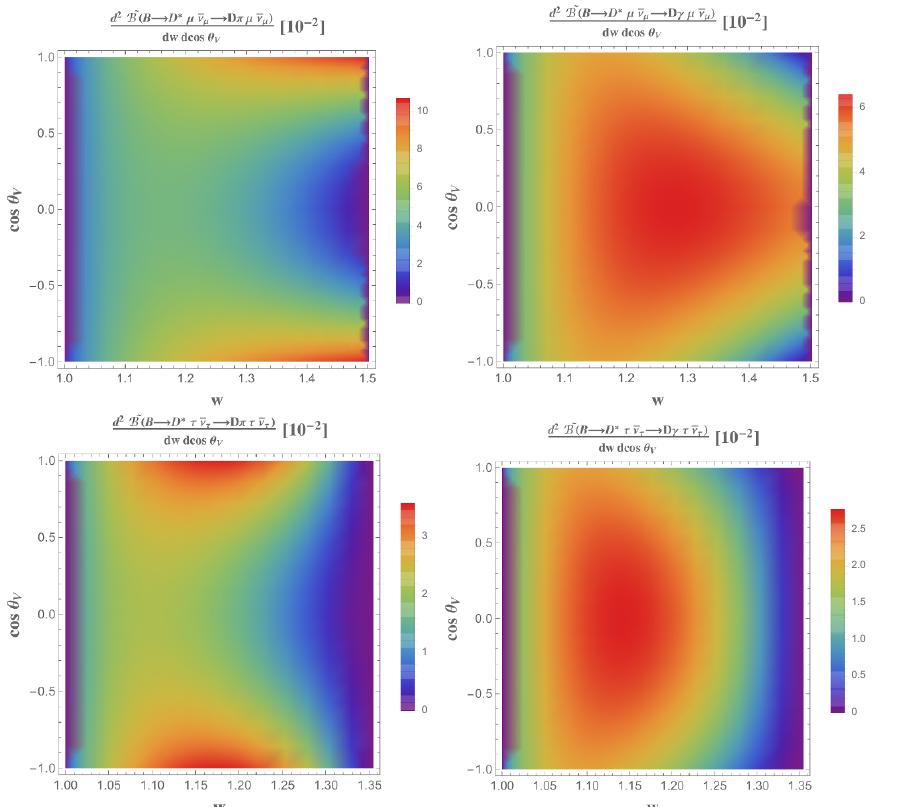
Figure 4 . SM scatter plots of the double di(cid:11)erential distributions in w and cos (cid:18) V , with ~ B = B = B ( D (cid:3) ! DF ), using the CLN parametrization. The upper and lower plots refer to ‘ = (cid:22) and ‘ = (cid:28) modes, respectively, the left and right column to F = (cid:25) and F = (cid:13)